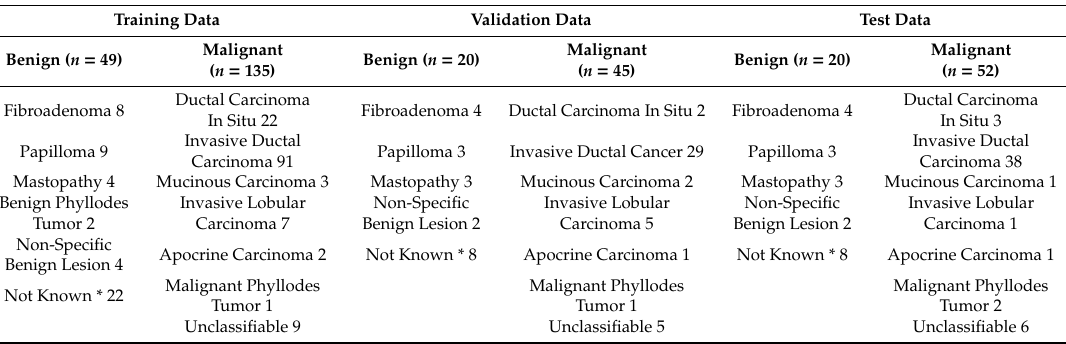
Table 1. Histopathology of benign and malignant lesions.